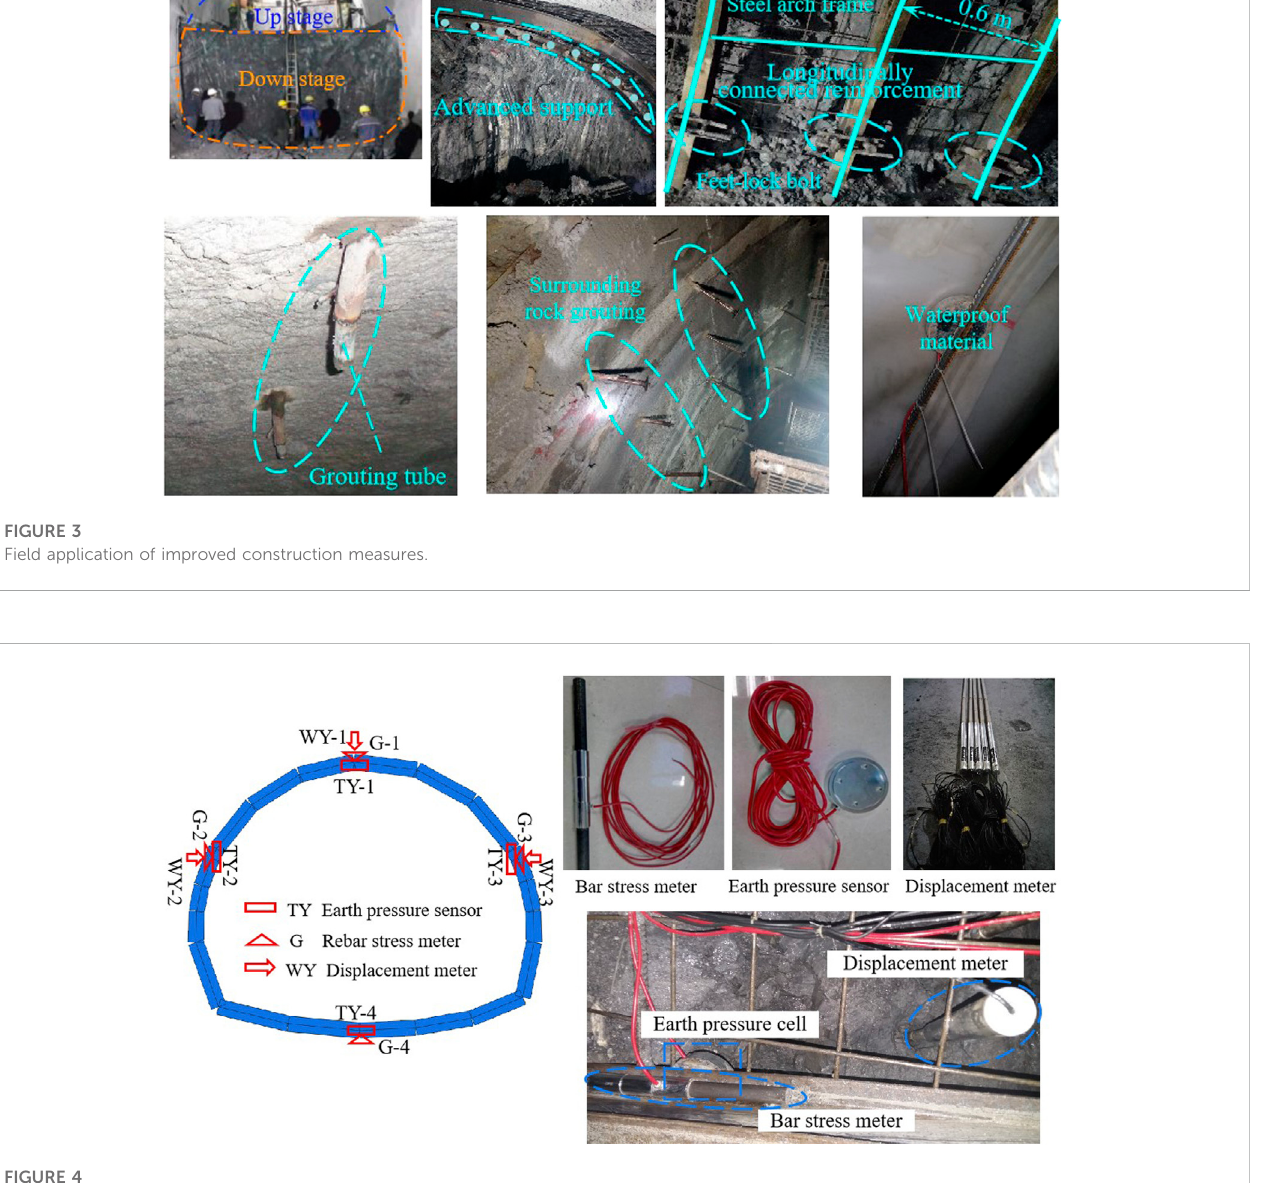
FIGURE 4 Layout of measuring points and installation of measuring